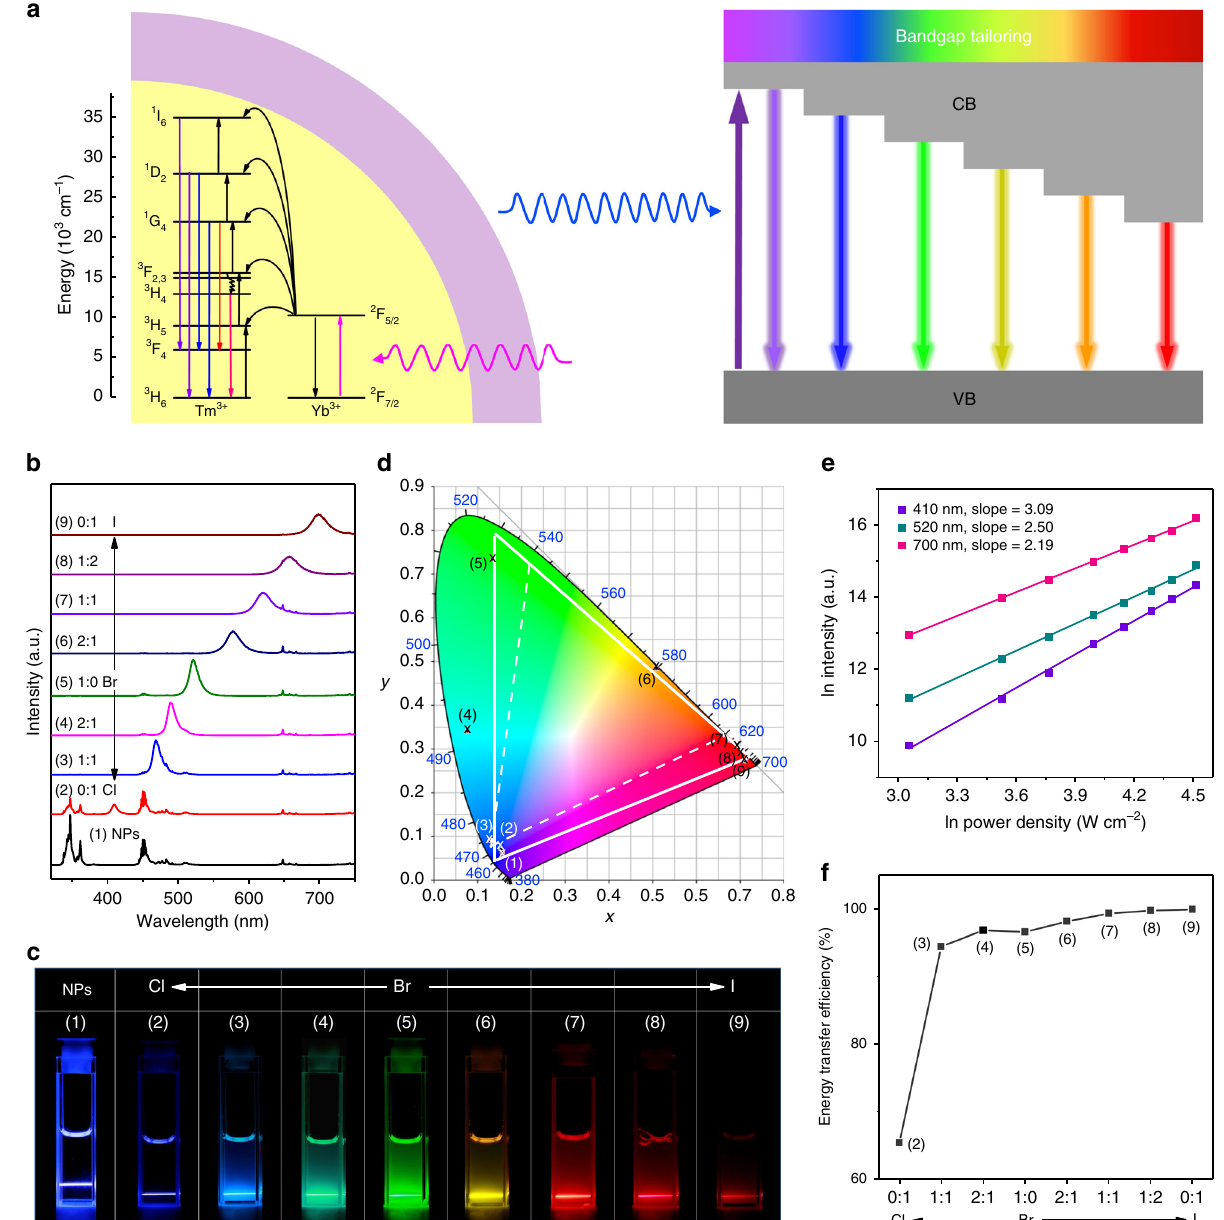
Fig. 3 Full-color upconversion tuning in CsPbX 3 perovskite quantum dots (PeQDs) through sensitization by lanthanide-doped nanoparticles (NPs). a Simpli fi ed energy-level scheme of LiYbF 4 :0.5%Tm 3 + @LiYF 4 core/shell NPs indicating major upconversion processes, and schematic illustration of full-color upconversion tuning in CsPbX 3 PeQDs through sensitization by the NPs. Black lines represent non-radiative energy transfer and the curved arrows denote internal conversion. b Upconversion luminescence (UCL) spectra for LiYbF 4 :0.5%Tm 3 + @LiYF 4 core/shell NPs and the NP-sensitized CsPbX 3 PeQDs (NPs: 1 mg mL − 1 ; PeQDs: 2 mg mL − 1 ) with varying halide compositions under 980 nm continuous-wave (CW) diode laser excitation at a power density of 50 W cm − 2 . c Photographs of samples (1 – 9) under 980 nm illumination, showing color tuning through bandgap tailoring of PeQDs. d Corresponding color gamut of the emission colors (solid white triangle) from the samples shown in ( c ), compared with the color gamut (dashed white triangle) de fi ned in the NTSC television color standard. e Double logarithmic plots of intensity vs. excitation power for the upconverted exciton